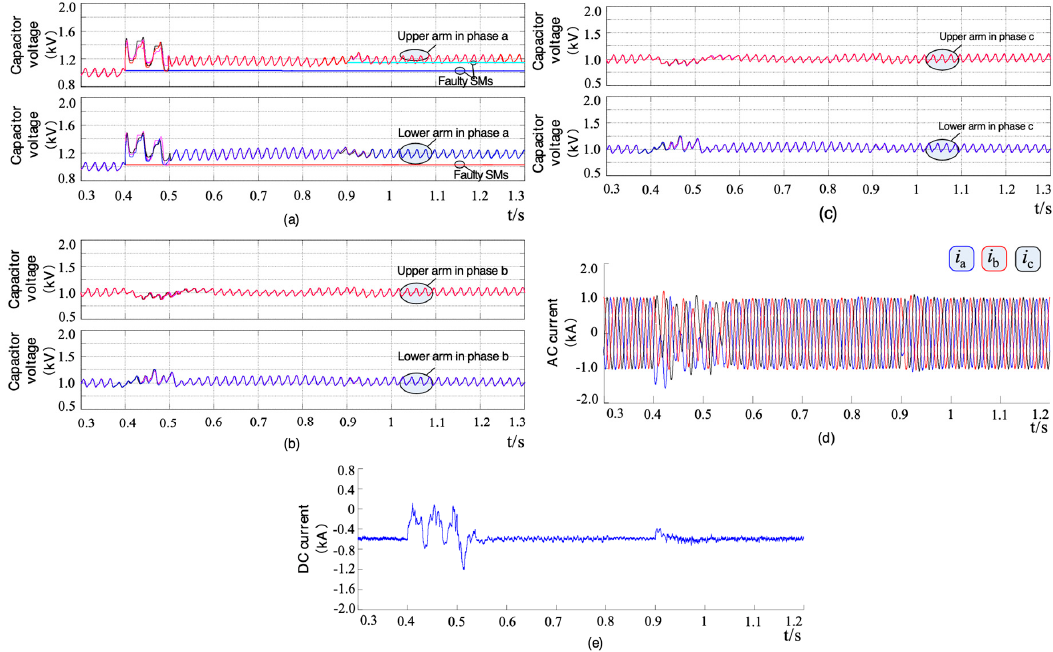
Figure 11. Simulation results of fault condition 3: ( a ) Capacitor voltage of phase a; ( b ) Capacitor voltage of phase b; ( c ) Capacitor voltage of phase c; ( d ) AC current; ( e ) DC-link current.